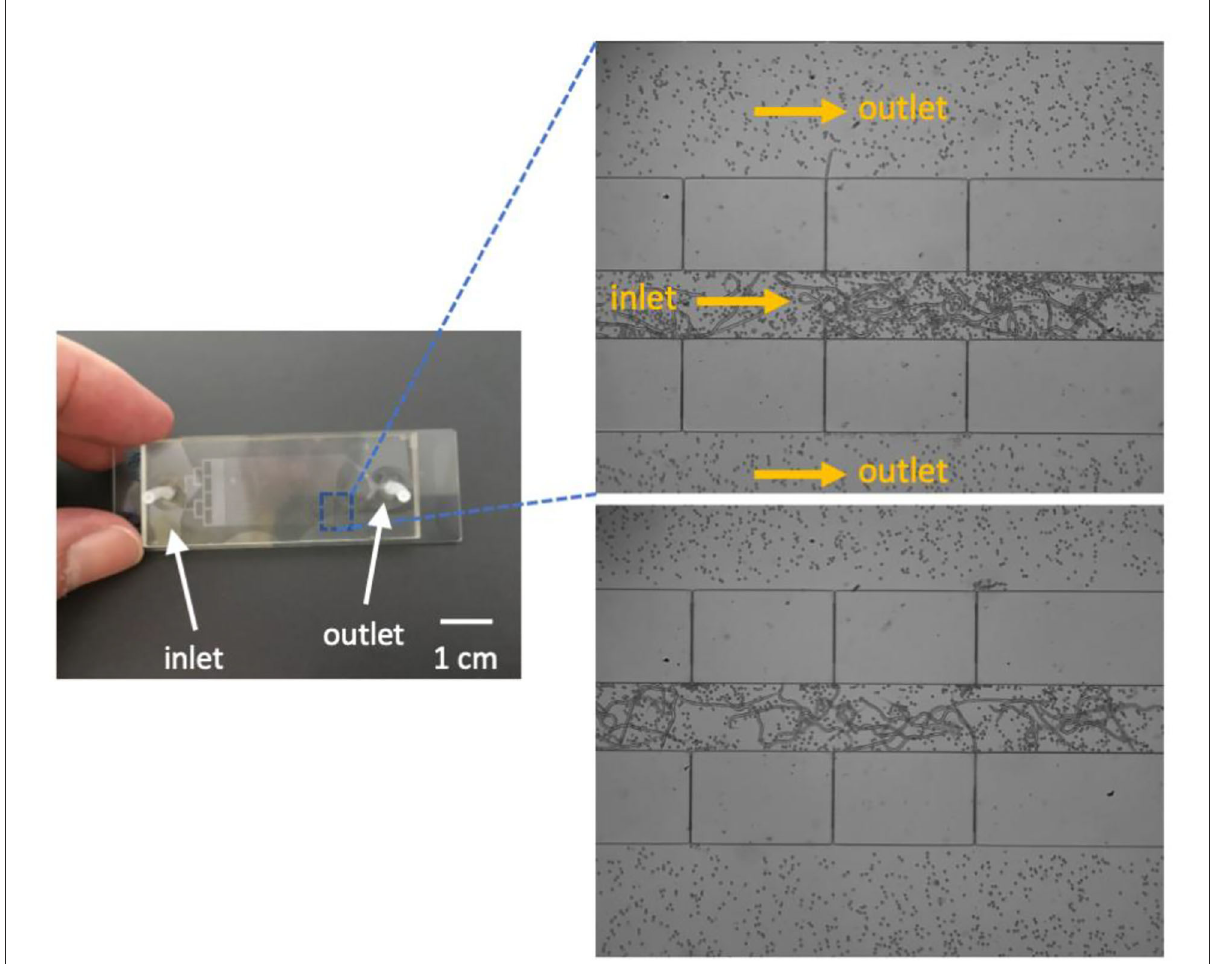
FIGURE3 A prototype of the microfluidic chip (left) and trapped microfilariae (right) . Fluid flow direction is indicated by arrows in the